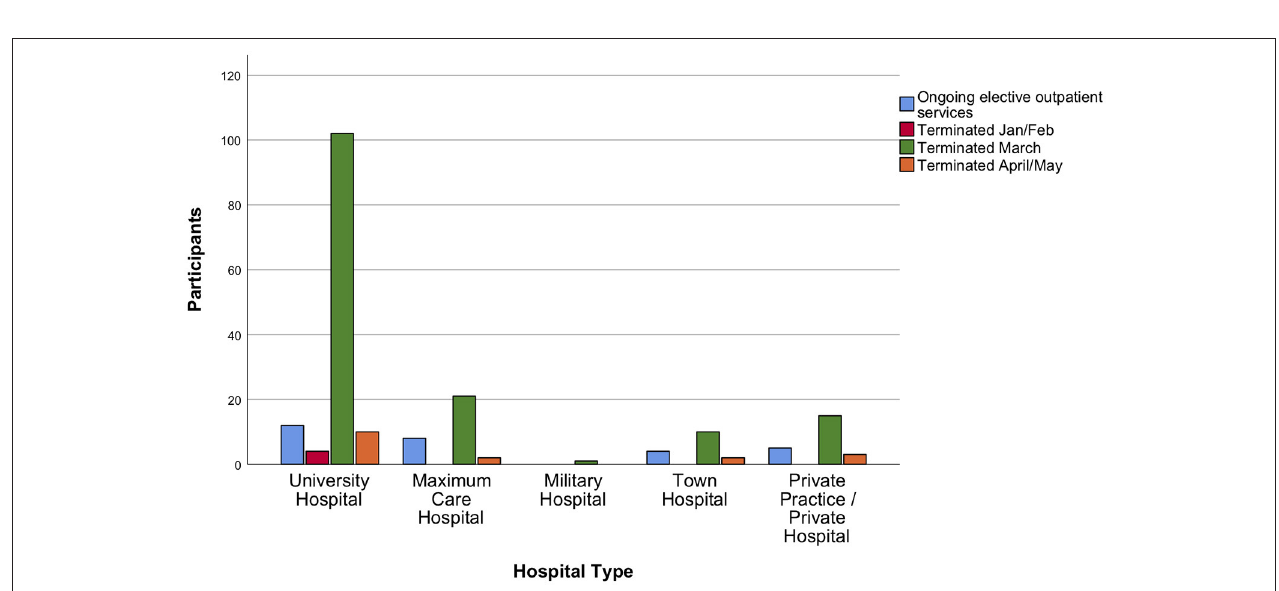
had relevant impact on the earlier shutdown of neurosurgical elective activities.